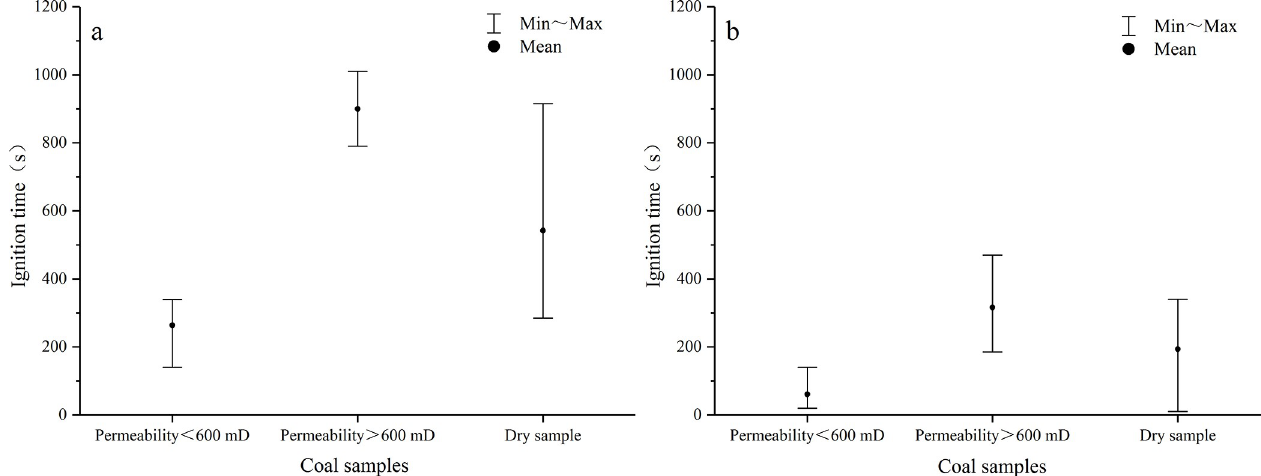
Fig 13. Effects of permeability threshold on ignition time. a and b are the distribution of ignition time of coal sample under low power (1.5–1.8kW) and high power (2–2.5kW) microwave heating, respectively.